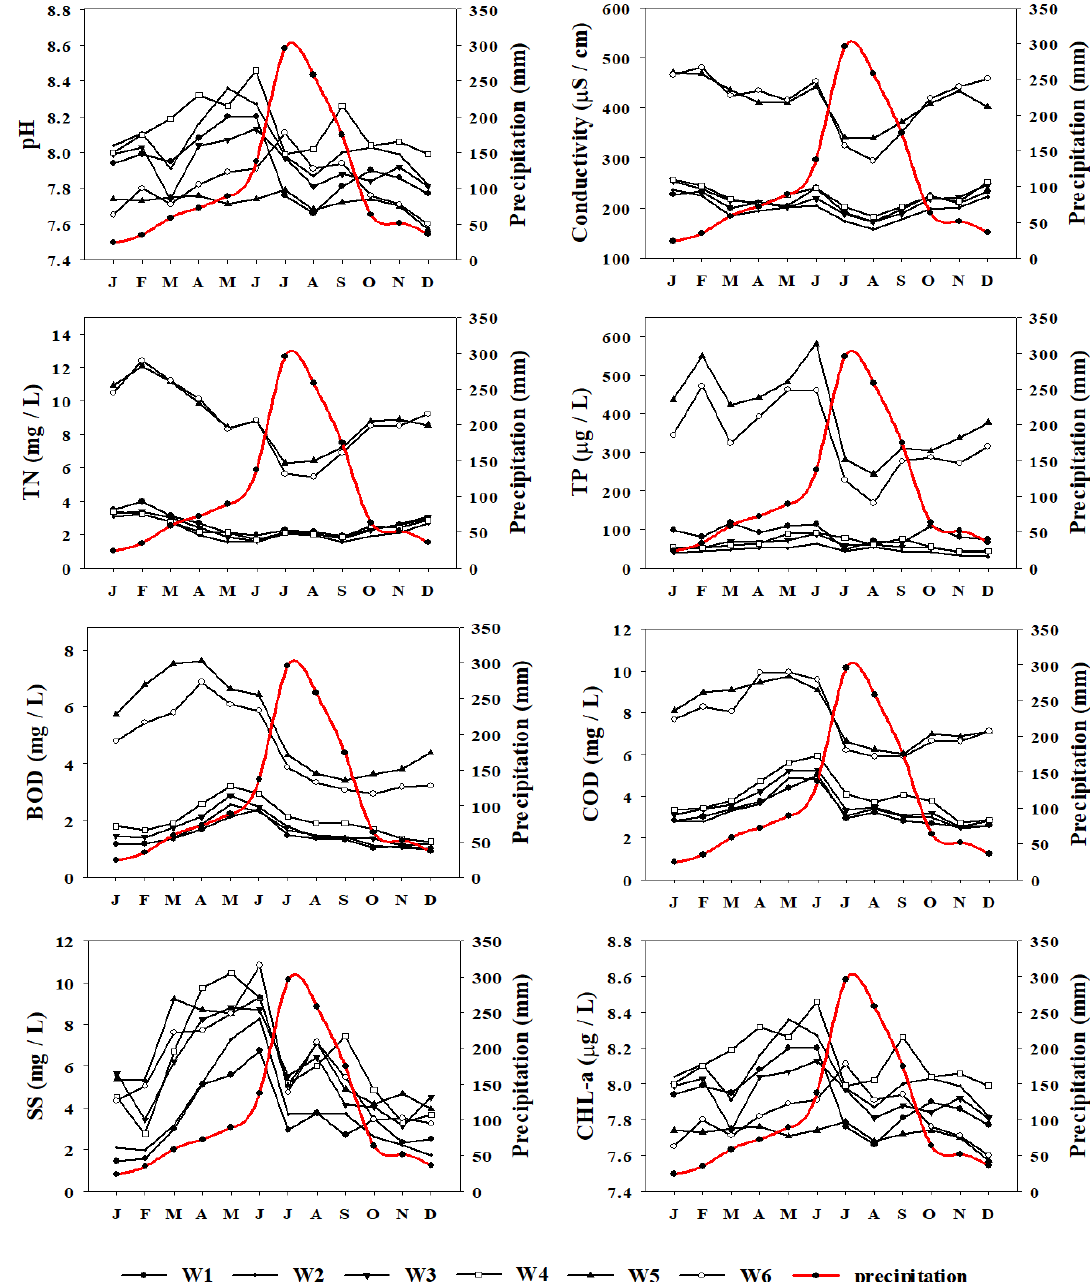
Figure 2. Monthly variation in selected water quality parameters in relation to monthly precipitation shown as (Spline red curve) in Gap stream during 2007–2016. TN = Total nitrogen, TP = Total phosphorus, BOD = Biological oxygen demand, COD = Chemical oxygen demand, SS = Suspended solids, CHL-a = Chlorophyll-a, W1–W6 = Water quality sites.